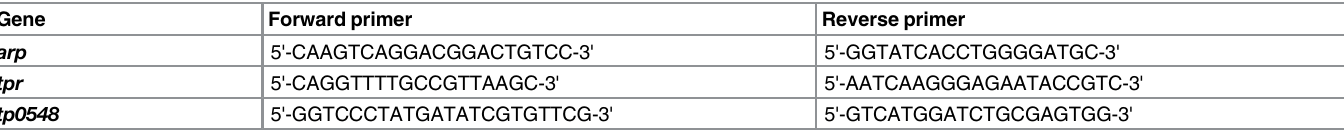
Table 1. Primers used in the